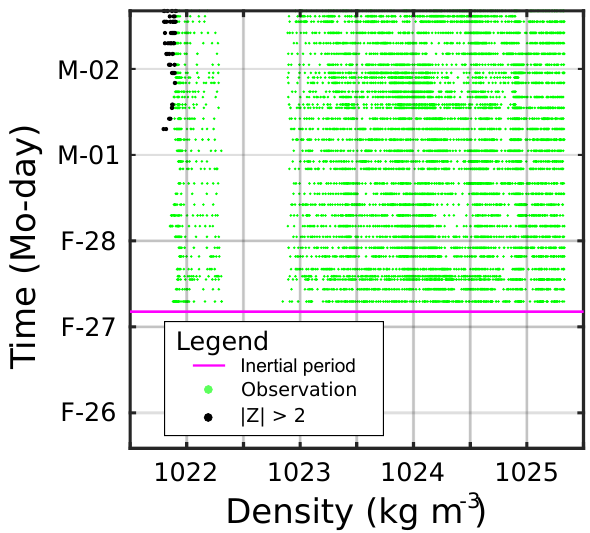
Figure 11. Same as Fig. 9 for LDC, with | Z | < 2 observations plot- ted in blue.